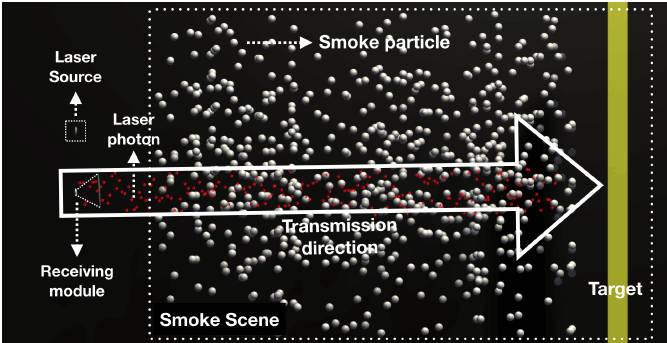
Figure 9. Photon motion process based on reverse ray-tracing in Unity3D.